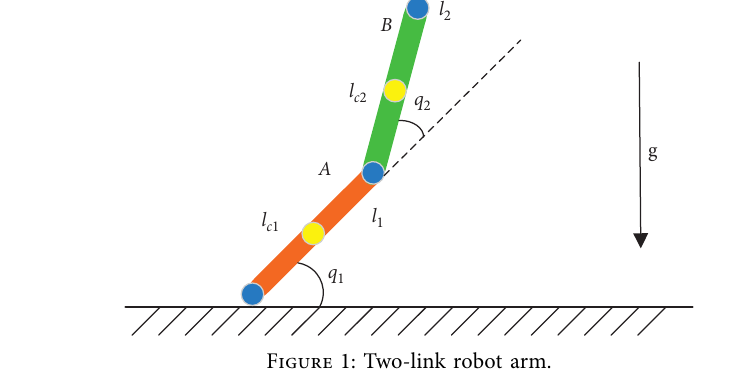
Figure 1: Two-link robot arm.